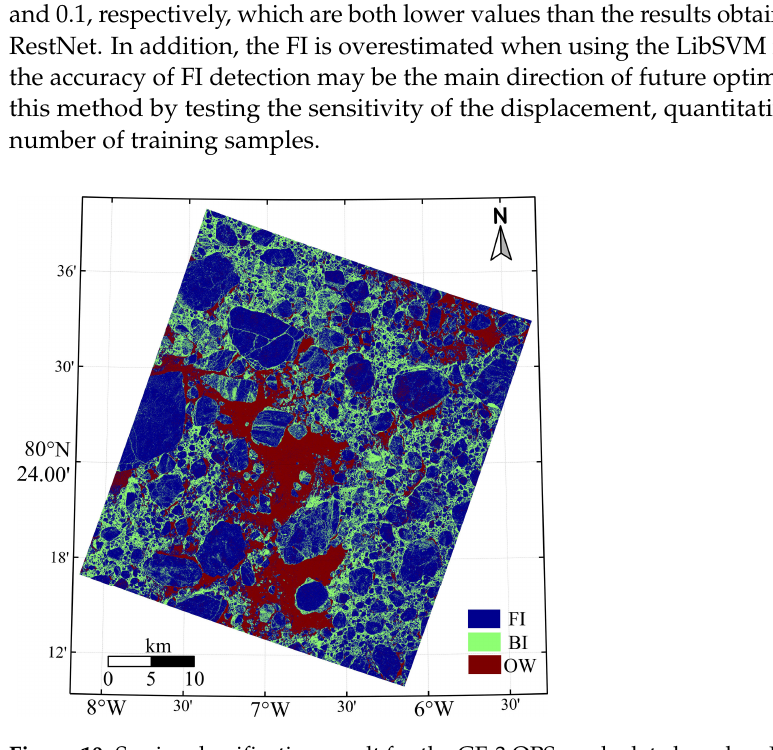
Figure 10. Sea ice classification result for the GF-3 QPS mode data based on LibSVM using the VV, VH, and HH polarization data of the R3-15